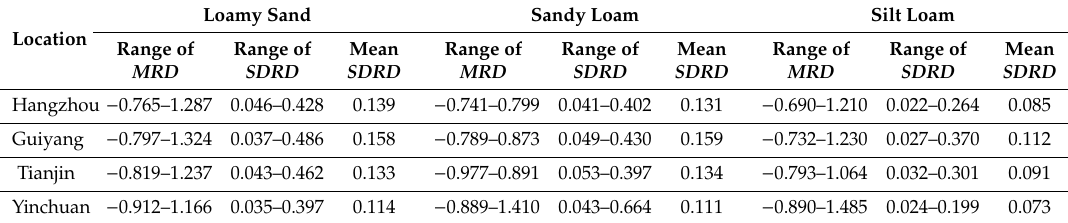
Figure 2. Ranked mean relative di ff erence ( MRD ) of soil moisture with one standard deviation (vertical bars) for di ff erent soil textures at the study sites. Simulated soil moisture data at 25 cm were used to compute MRD . Table 3. Statistical summary of mean relative di ff erence ( MRD ) and standard deviation of relative di ff erence ( SDRD ) of soil moisture. Simulated soil moisture data at 25 cm were used to compute MRD and SDRD